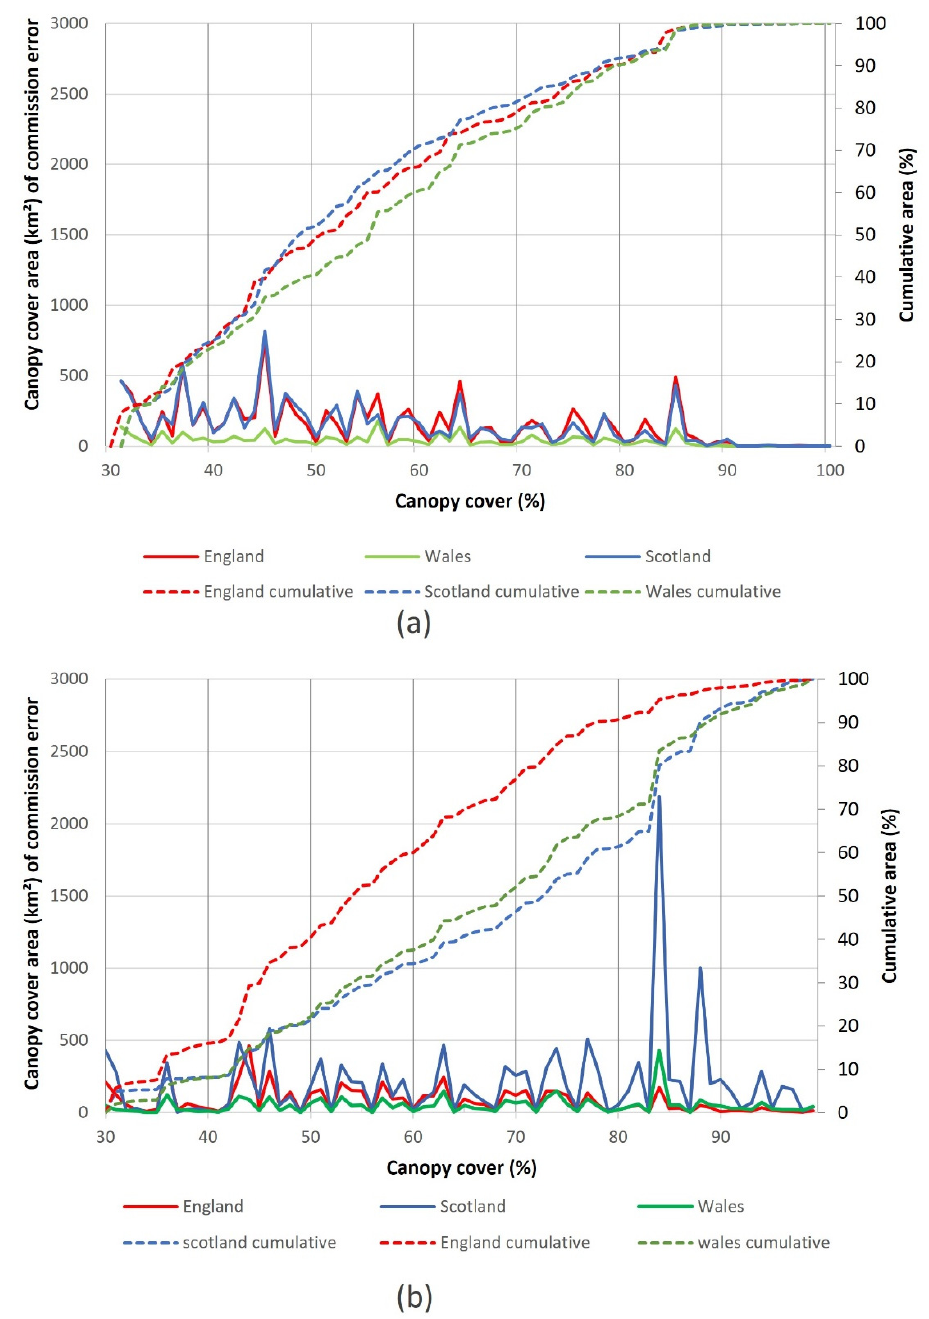
Figure 7. Areas of commission error between NFI and GLAD FC against percentage of canopy cover for ( a ) 2010 and ( b ) 2000.